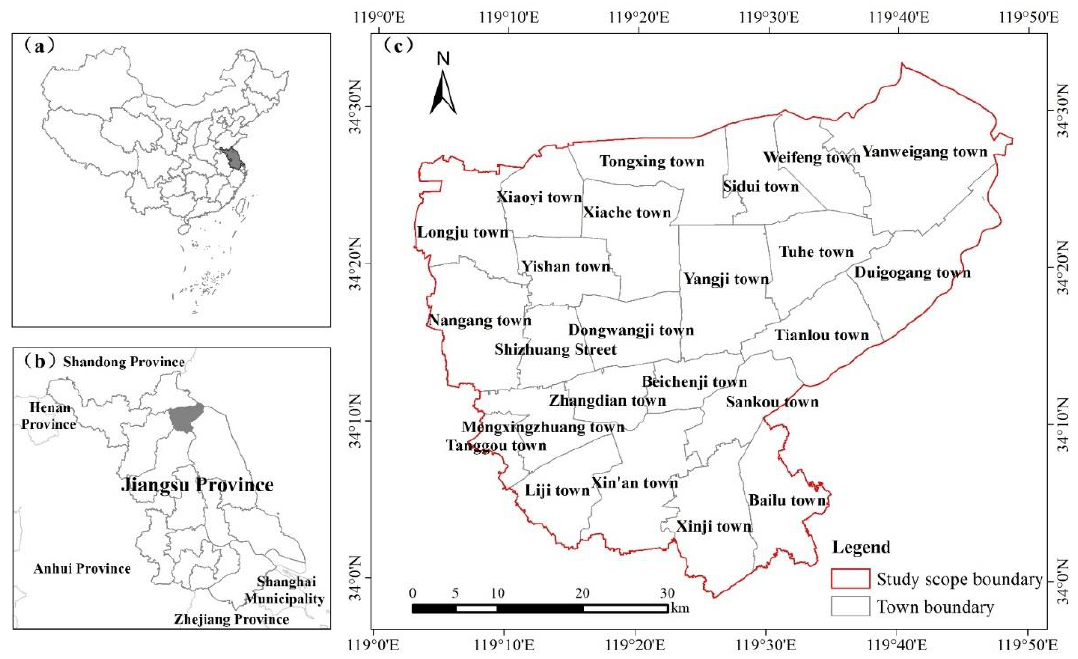
Figure 1. Location and extent of the research area. ( a ) Location of Jiangsu Province in China, ( b ) location of the study area in Jiangsu Province, and ( c ) specific location of the study area.